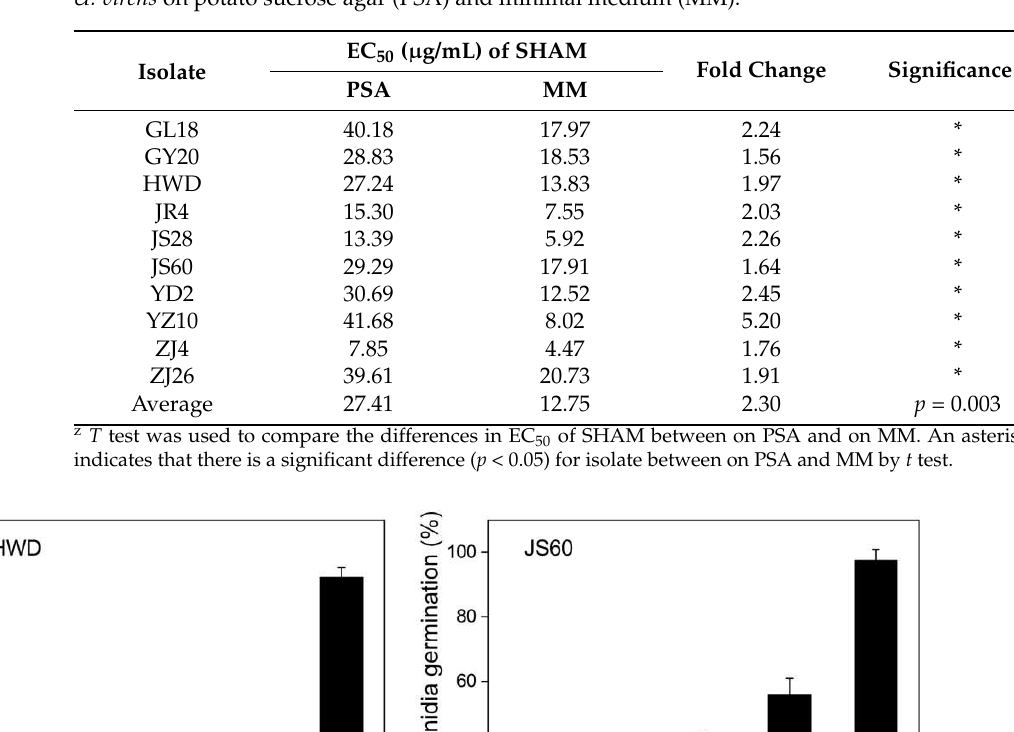
Table 2. Effective concentrations for 50% inhibition (EC 50 ) of SHAM against mycelial growth of U. virens on potato sucrose agar (PSA) and minimal medium (MM). EC 50 ( µ g/mL) of SHAM Isolate